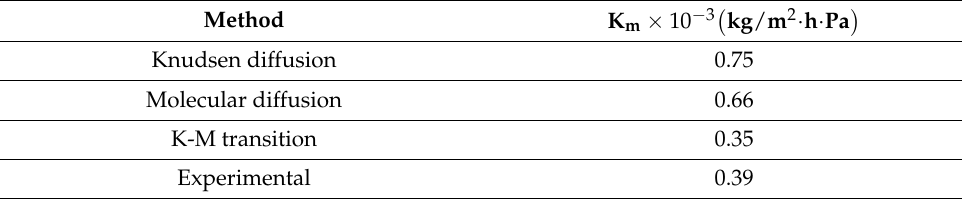
Figure 4. Pure water flux versus different feed temperature at m f = 60 L/h and P = 1 bar (K m = 0.39 kg/m 2 · h · Pa. Table 6. Comparison between the theoretical and experimental value of the mass transfer coeffi- cient.